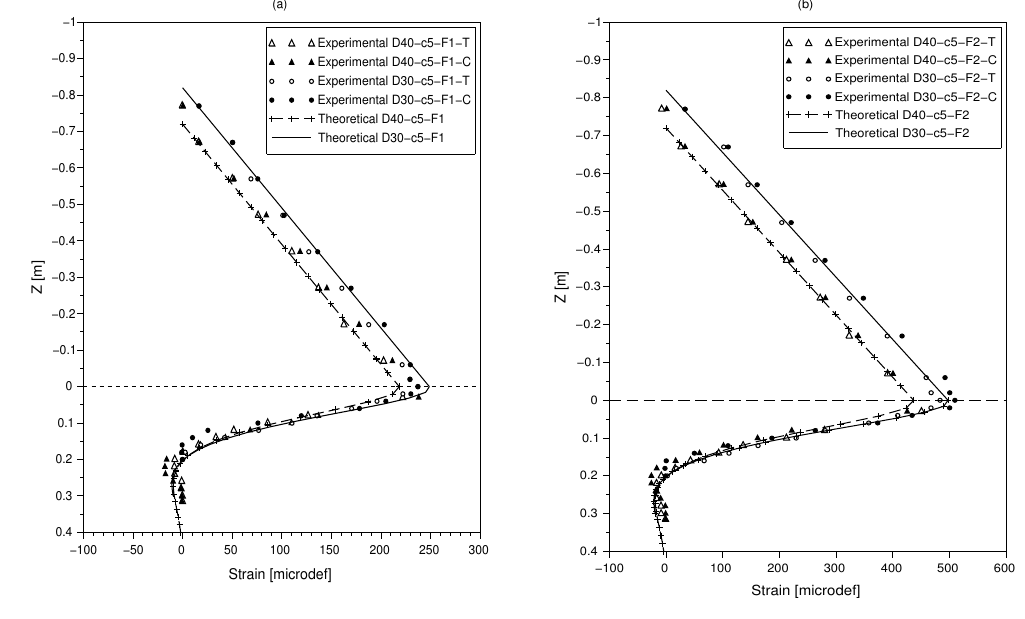
Figure 2. Strain profiles along the rod under tension ‘T’ and compression ‘C’ provided by the fiber optic for the load F [( a ) F = F 1 ( b ) F = F 2] applied at c = 5 cm from the tip of the rod for an embedded length of D = 40 cm and D = 30